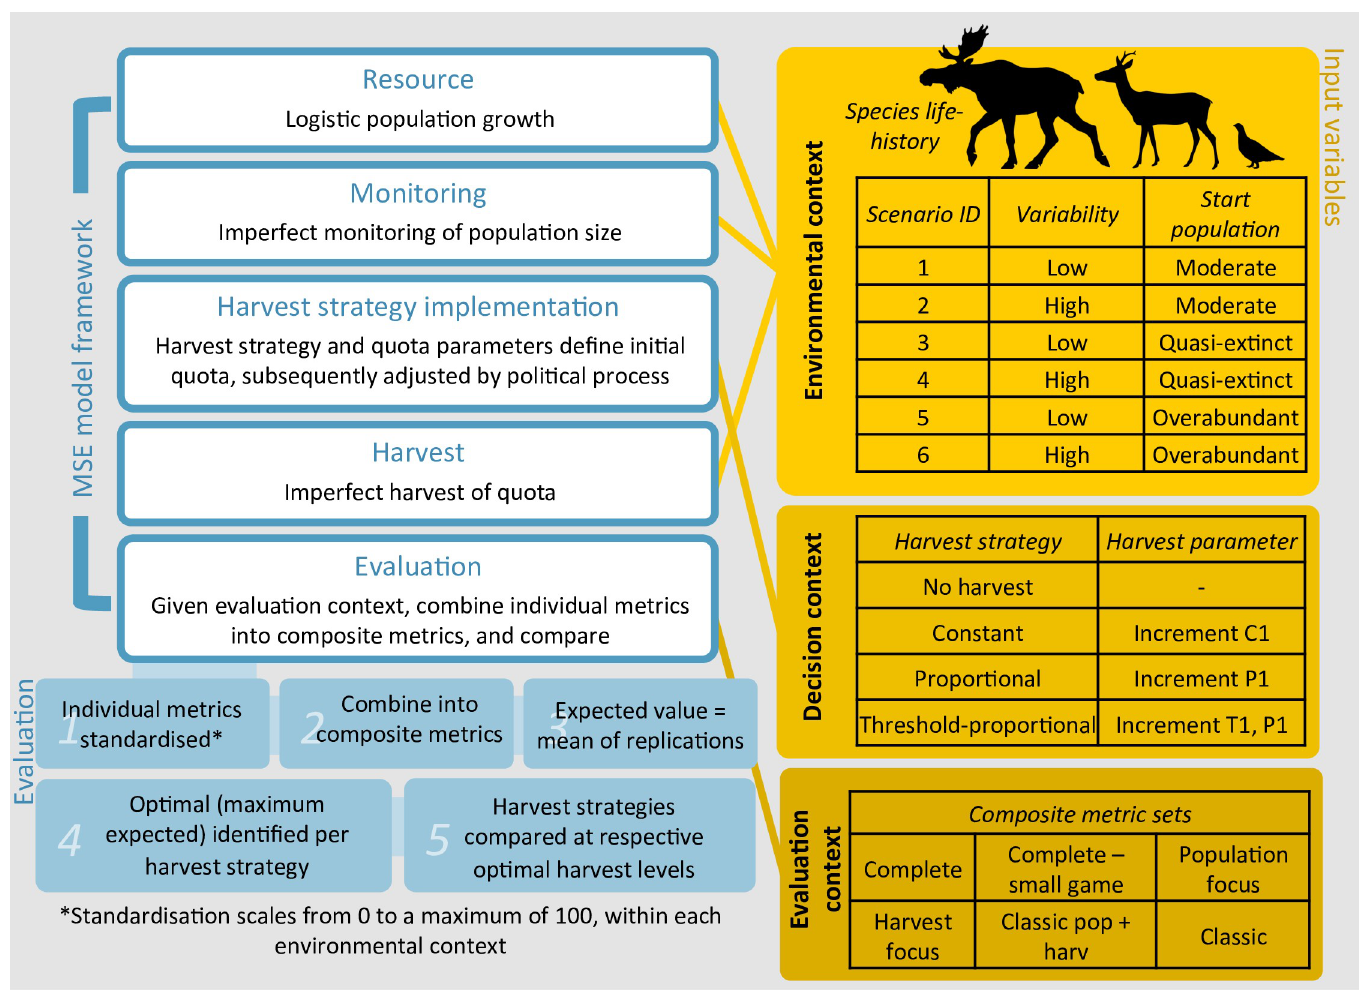
Fig 1. MSE framework. The Management Strategy Evaluation (MSE) model simulates a wildlife harvest system over a 20 year timeframe, with each environmental and decision context including 1000 stochastic replications. Evaluation contexts are simulated through combinations of different evaluation metric sets. Species types span a fast-slow life-history gradient, determining growth rates and carrying capacity, variation levels in growth rates and monitoring variability, and critical thresholds. Stochastic parameters simulate yearly stochasticity and iteration level uncertainty. A full description of the model and parameter values are specified in S1 Appendix.